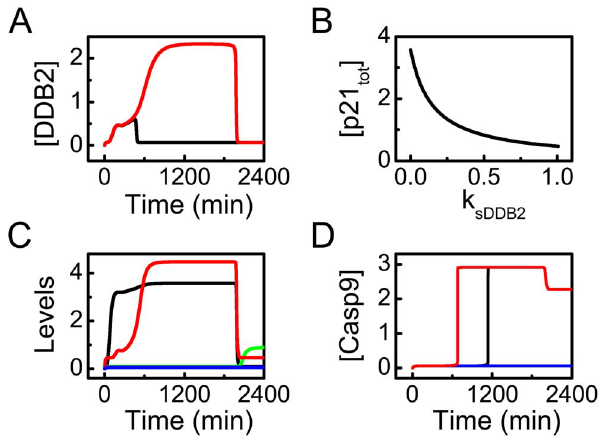
Figure 6. DDB2 promotes apoptosis via mediating the degradation of p21. (A) Time courses of [DDB2] at L D0 ~ 5 (black) or 20 (red). (B) Bifurcation diagram of [p21 tot ] vs. the p53-inducible production rate of DDB2, k sDDB2 . (C) Time courses of [p21 tot ] (black), [E2F1] (green), [Bax] (red), and [Casp9] (blue) with k sDDB2 ~ 0 at L D0 ~ 20 . (D) Time courses of [Casp9] with the normal parameter setting (i.e., k sDDB2 ~ 0 : 6 and k sp21 ~ 0 : 4 ) (black), k sDDB2 ~ 0 and k sp21 ~ 0 : 4 (blue), or k sDDB2 ~ 0 and k sp21 ~ 0 (red).